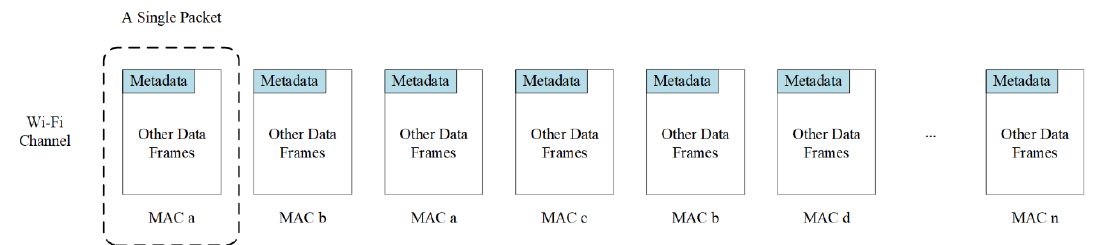
Figure 3. Illustration of an example state for data packets in a Wi-Fi channel.